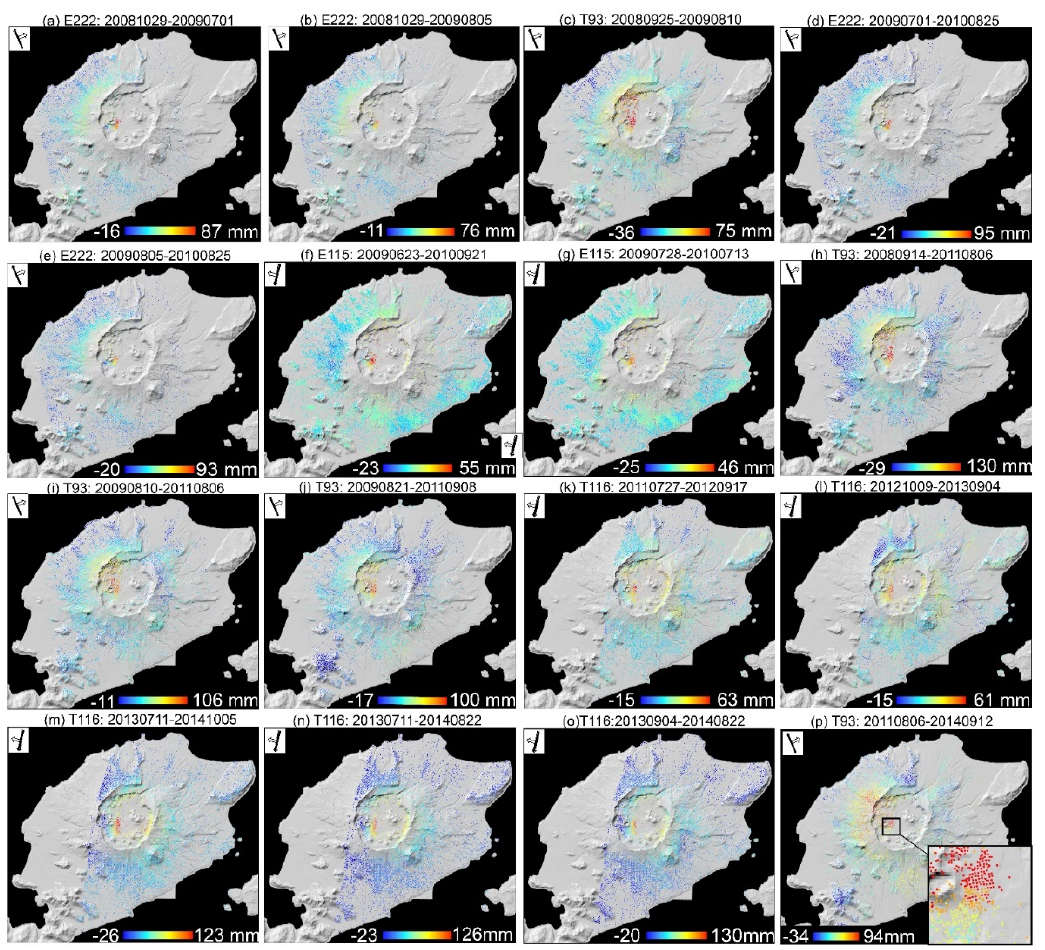
Figure 3. Selected interferograms showing surface deformation of Okmok volcano from 2008 to 2014 ordered by start date: ( a ) 20081029–20090701 (Envisat 222), ( b ) 20081029–20090805 (Envisat 222),